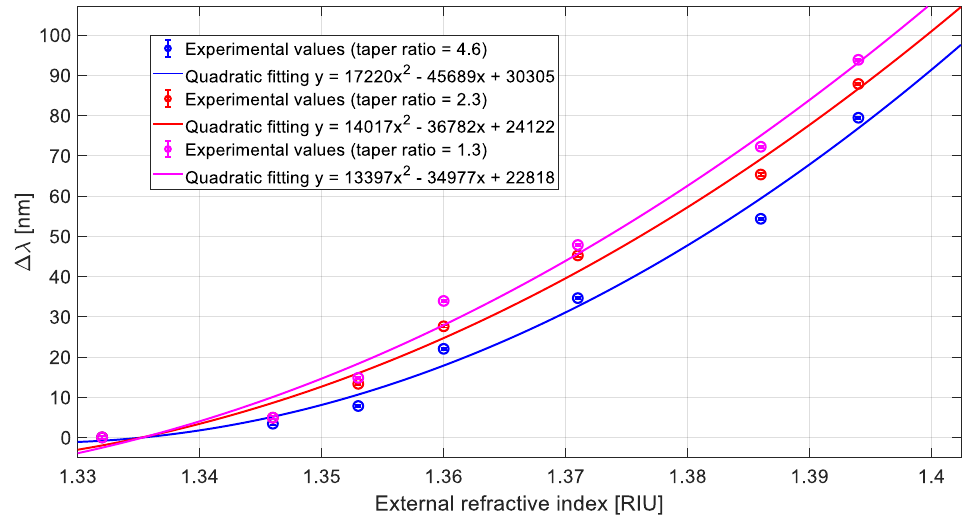
Figure 3. Variation in SPR wavelength (Δλ) versus external refractive index and quadratic fitting of the experimental data for three different configurations based on tapered LDFs.